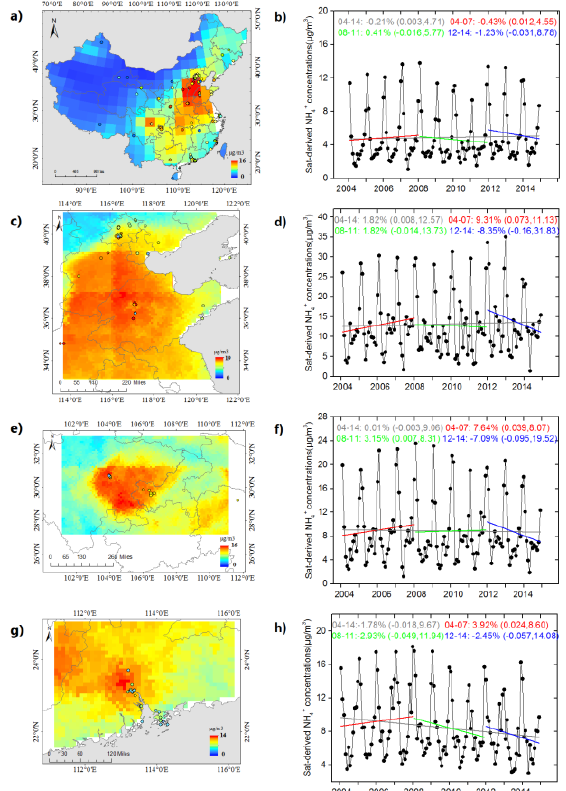
Figure 5. The same results as shown in Figure 4 but for NH 4+ . ( a ) Overlaid with ground measurements. ( b ) Time series of monthly satellite-derived SO 4 2− concentrations at the same resolution over China during the period 2004–2014. ( c , d ) Similar results to those presented in ( a , b ) but in the NCP at 0.1° × 0.1°. ( e , f ) Same as ( c , d ) but in the SCB. ( g , h ) Same as ( c , d ) but in the